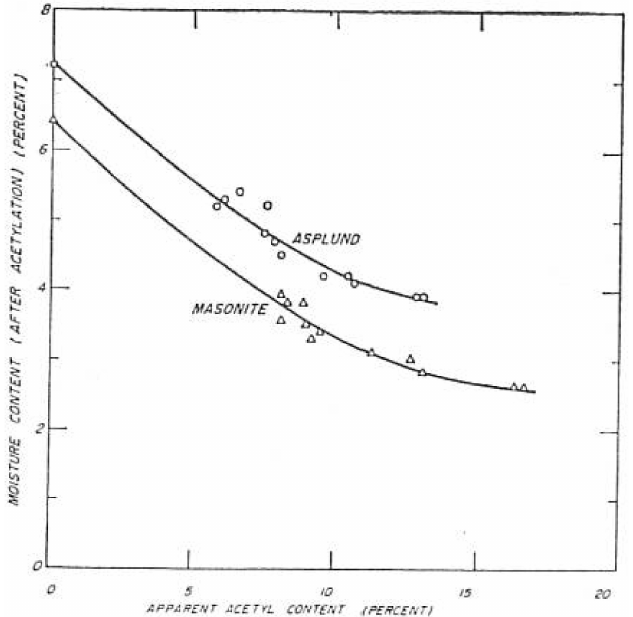
Figure 16. Moisture content in Asplund and Masonite hardboards after acetylation as a function of apparent acetyl content [17].